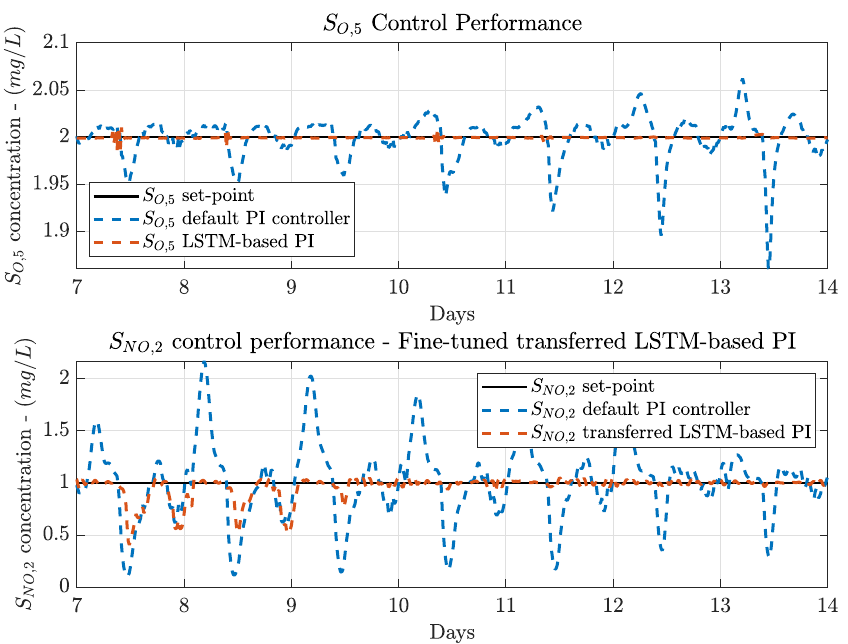
Figure 9. Control performance for the NO and DO control loops when a S O ,5 fix set-point and dry weather are considered. The LSTM-based PI managing the NO loop is transferred from the DO control loop and fined-tuned with data from the NO control